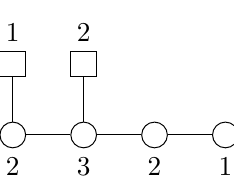
Figure 2. Quiver corresponding to brane con(cid:12)guration depicted in (cid:12)gure 1. The circles are gauge nodes while the squares are (cid:13)avor nodes